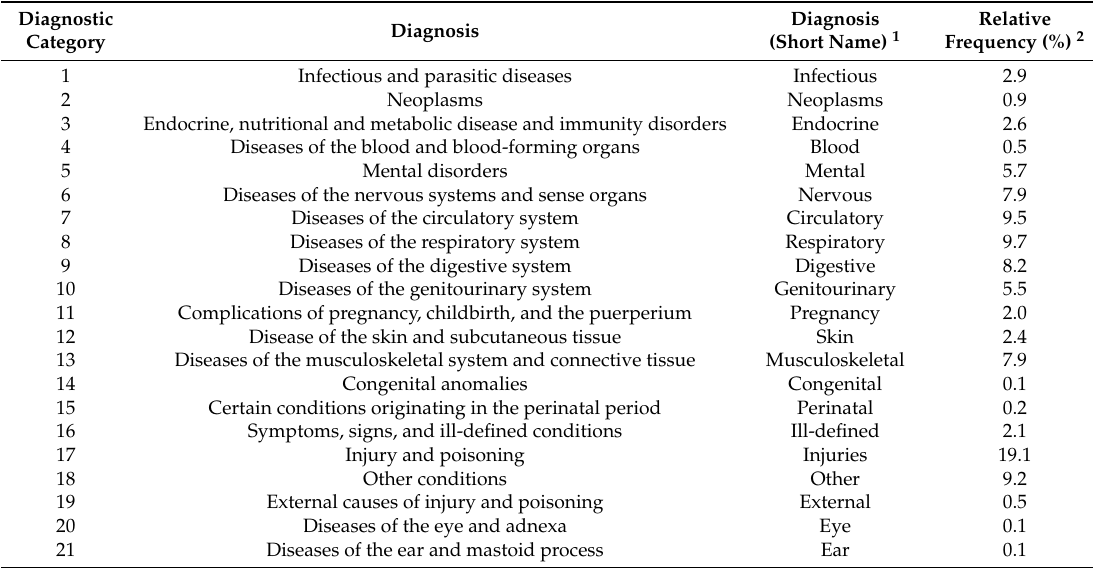
Table 1. List of diagnostic categories and their relative